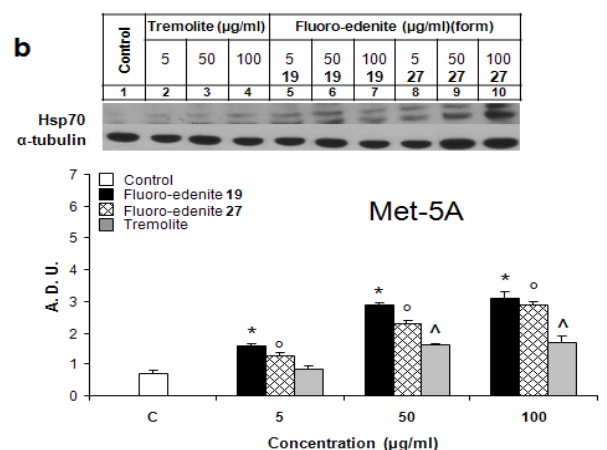
Figure 1: Hsp70 levels in J774 (a) and Met-5A (b) cells evaluated by Western blot analysis. Bands were measured densitometrically and the relative density was calculated based on the density of α -tubulin bands in each sample. The values were expressed as arbitrary densitometric units (A.D.U.) obtained by analysis of the autoradiograms with lD image analysis software. The bars represent the mean ± SEM of three experiments performed in triplicate. All values with P<0.01 were considered significantly different. *°^ denote significant differences of values compared to untreated control. Numbers 19 and 27 refer to two chemically distinct forms of fluoro-endenite.